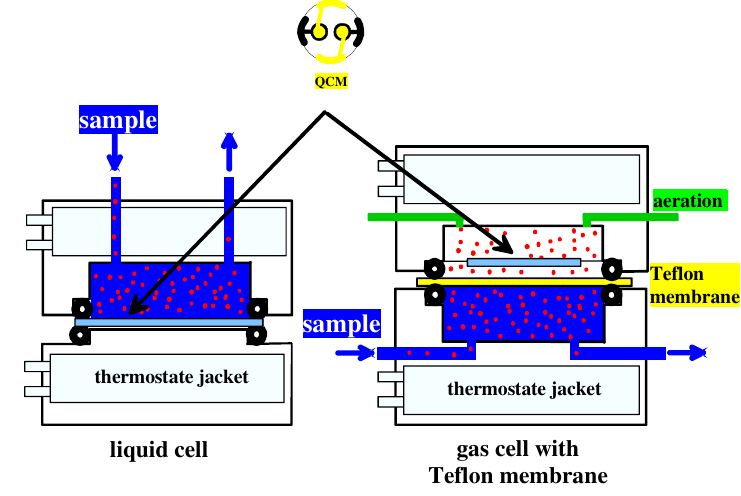
Figure 1 : Liquid and gas cell for determining organic trace contaminants in wastewater This is favorable due to the substantially lower noise level occurring in the oscillators driving the respective mass-sensitive device, which results from decreased electronic loss of the sensor caused by viscous interactions between the sensor and its environment [5]. Figure 1 shows both the